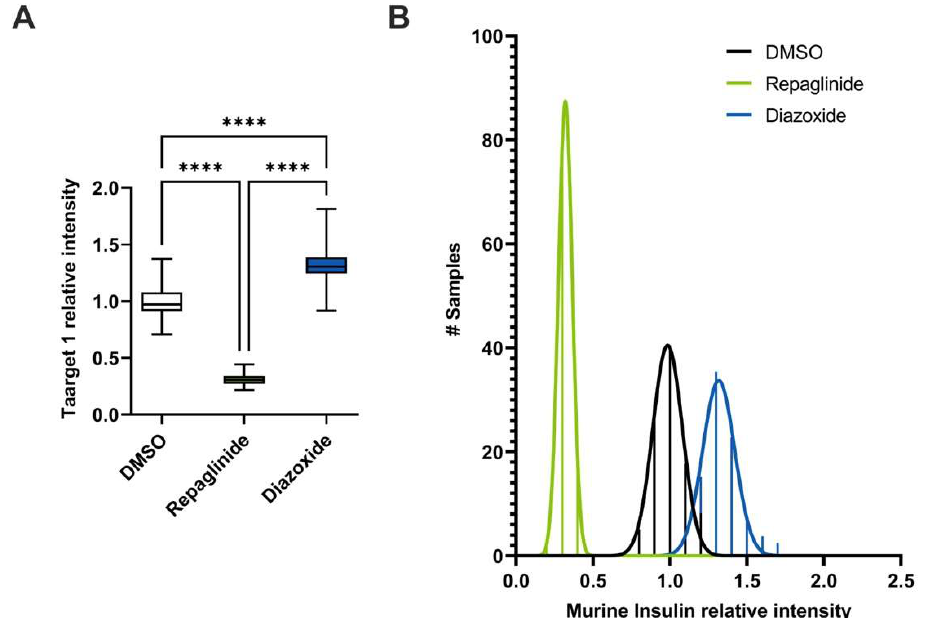
Figure 5. Analysis of insulin content of Min6 cells treated with diazoxide and repaglinide through MALDI-TOF mass spectrometry. ( A ) Quantification of intracellular insulin content of Min6 cells treated with DMSO, 100 µ M diazoxide and 100 nM repaglinide through MALDI-TOF mass spectrometry. ( B ) Normal distribution of analysis of intracellular insulin content from Min6 cells treated with DMSO, repaglinide and diazoxide. Statistical analyses were performed using two-way ANOVA with Bonferroni post-test analyses. Results are presented as means ± SEM. n = 4 for ELISA, n = 160 for DMSO and n = 80 for repaglinide and diazoxide. **** p < 0.0001.